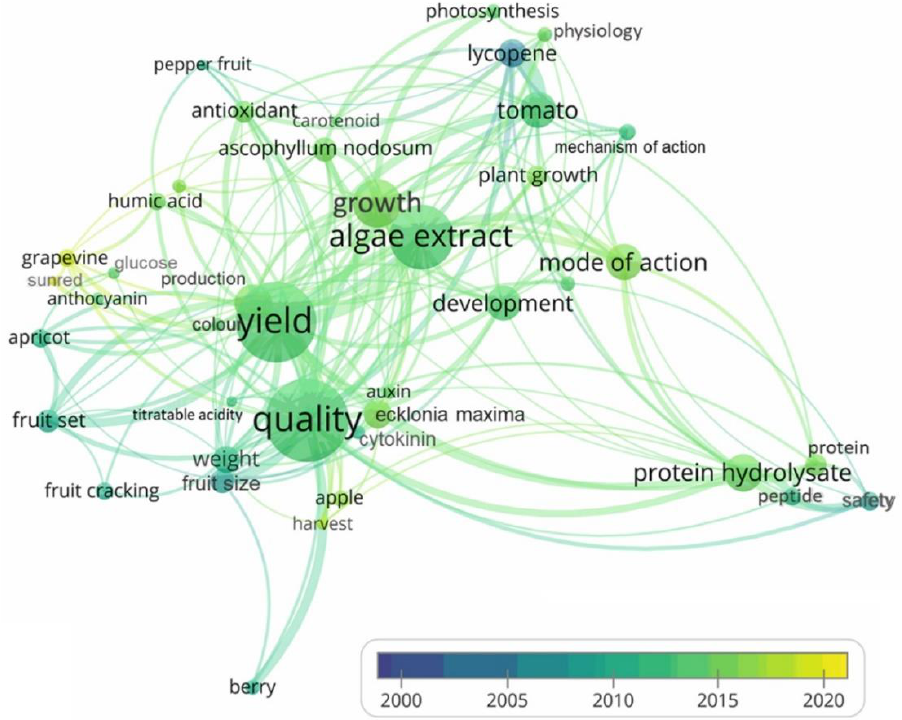
Figure 1. A network of the most commonly used terms in the field of biostimulants [69]. They are largely made from brown seaweeds such as Ascophyllum nodosum , Ecklonia maxima, and Macrocystis pyrifera and contain promoter hormones or trace elements such as Fe, Cu, Zn, and Mn [70]. In addition to Ascophyllum nodosum , other brown algae such as Fucus spp ., Laminaria spp ., Sargassum spp ., and Turbinaria spp . are used as biofertilizers in agriculture [71], as are the species Macrocystis pyrifera and Durvillea potatorum